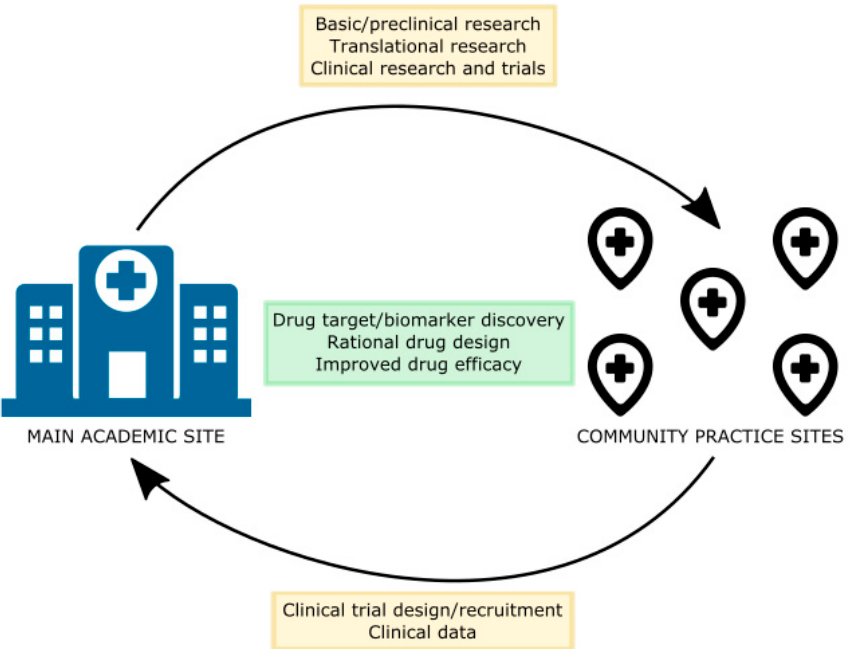
Figure 2. Collaboration between main academic site and community sites for clinical research.